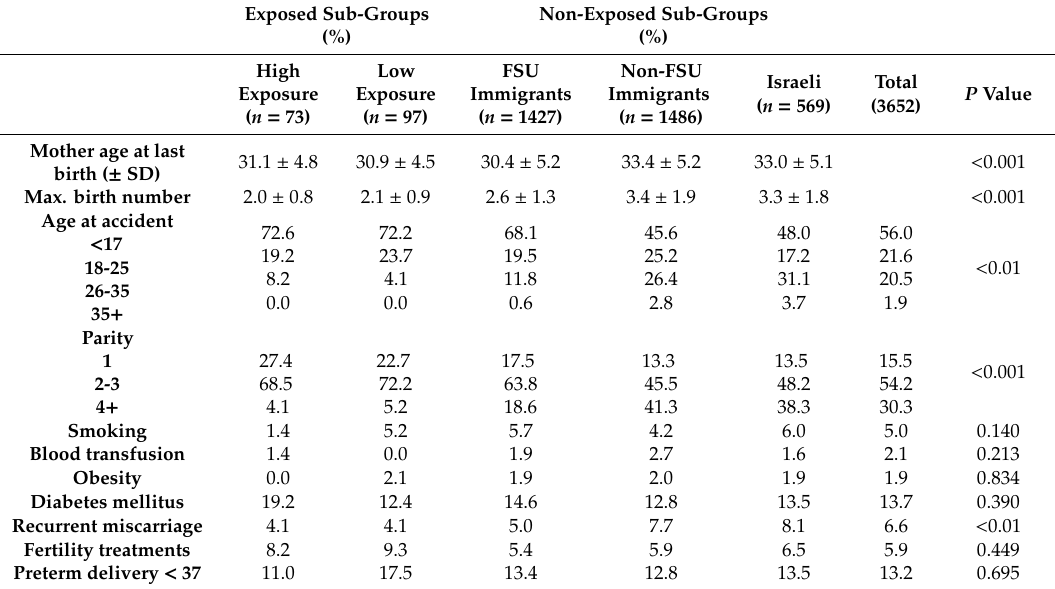
Table 1. Demographics and clinical characteristics of the study